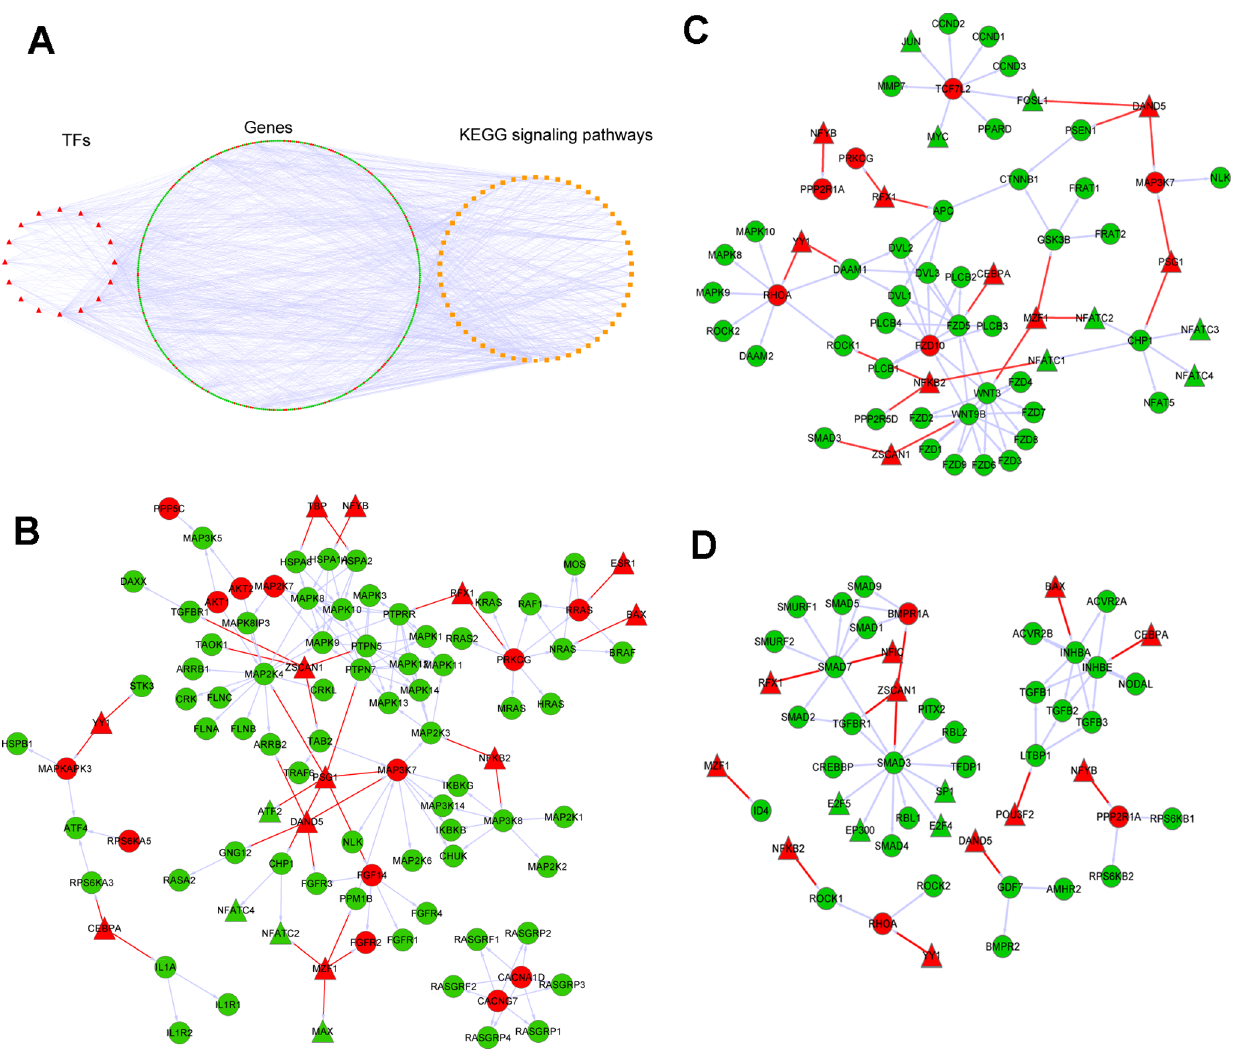
Figure 4. Integrative analysis of CNV-ICC-TRN and KEGG signaling pathways. (A). Integrated network of CNV-ICC-TRN and KEGG signaling pathways. Triangle represents TF, circle represents gene and rectangle represents signaling pathway; red color means gene inside CNV region, green color means gene outside CNV region. (B) Integrative analysis in MAPK signaling pathway. (C) Integrative analysis in Wnt signaling pathway. (D) Integrative analysis in TGF- b signaling pathway. In figure B, C, D, red edges are from CNV-ICC-TRN, and off-white edges are from signaling